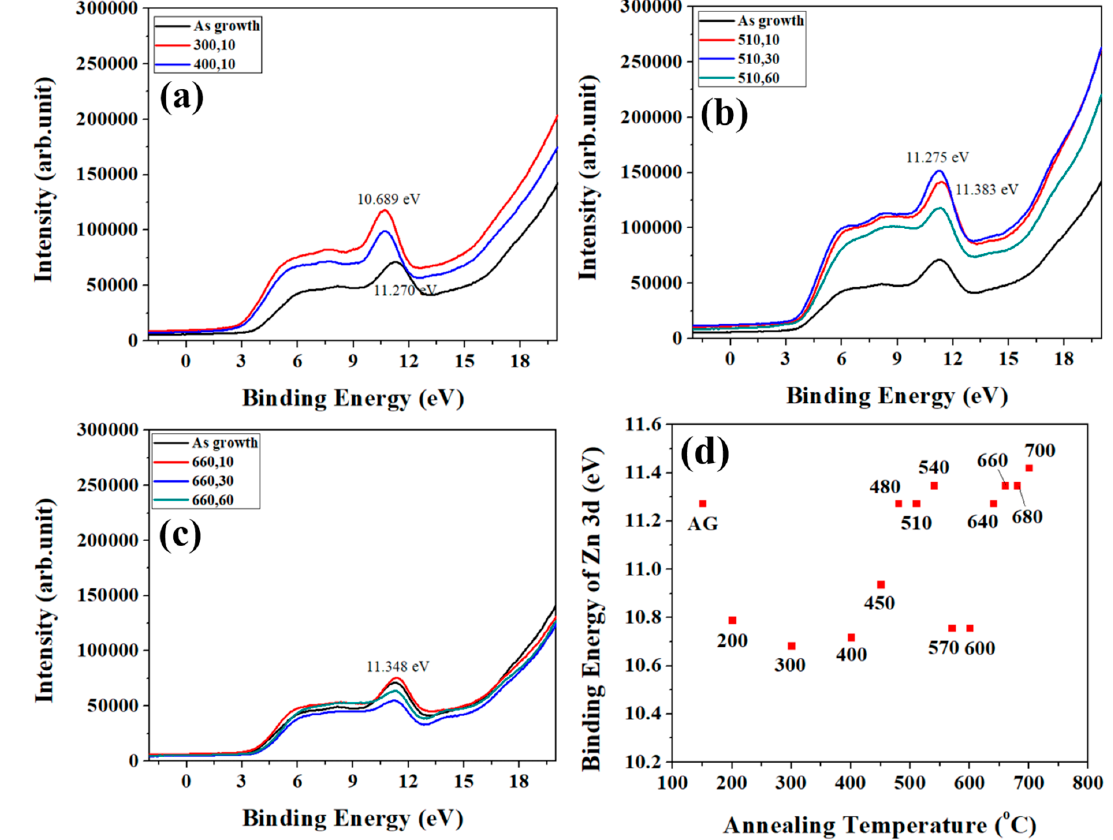
Figure 5. ( a ) UPS for annealing temperature of 300 and 400 °C. ( b ) UPS for annealing temperature of 510 °C with varied time. ( c ) UPS for annealing temperature of 660 °C with varied time. UPS for as-grown ZNRs is a reference in each diagram. ( d ) The trend of the binding energy of Zn3d for varied annealing temperature at 10 s.